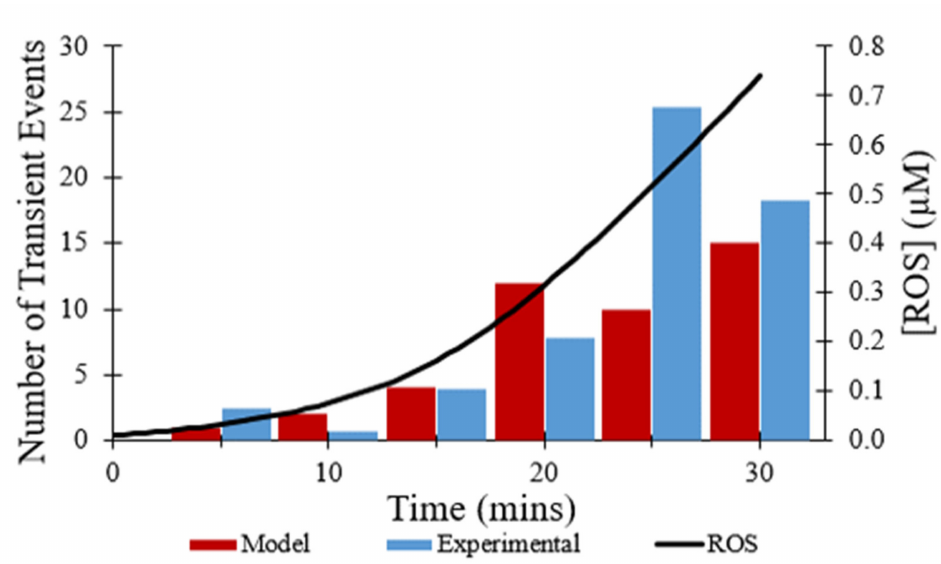
Figure 6. Frequency of transient openings per cell. Number of experimental transient depolarizations per cell per minute at times indicated (blue) [7]. Number of modeled transient depolarizations per cell per minute fit to data (red). Change in ROS concentration during time course of modeling (black). The event frequency at each time point was based on 50 total events.